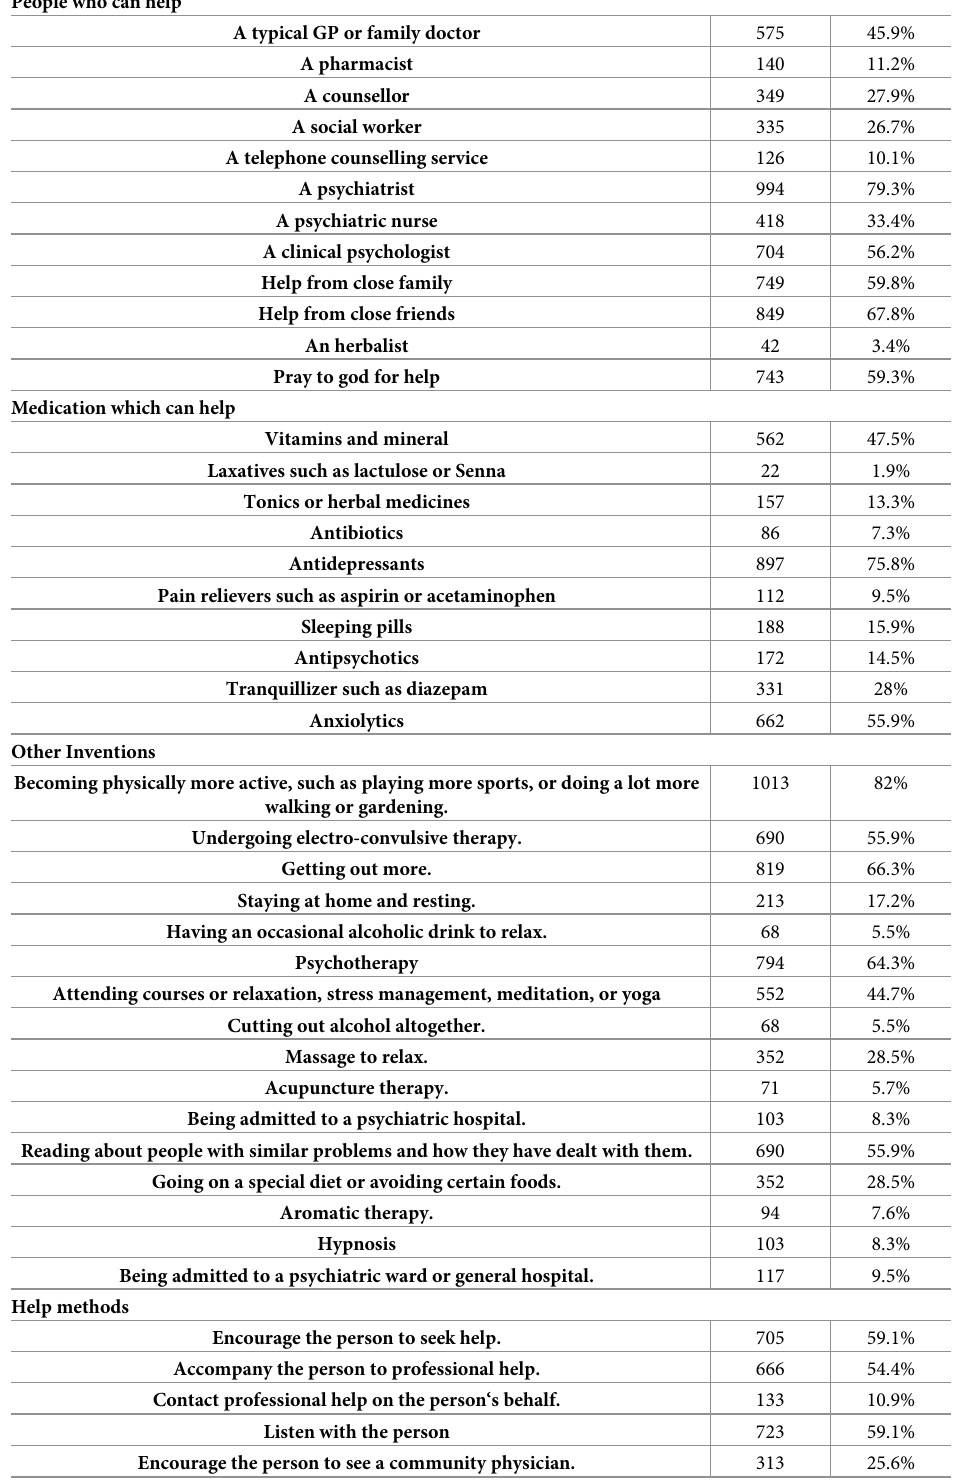
Table 6. Recommended helpful interventions by the